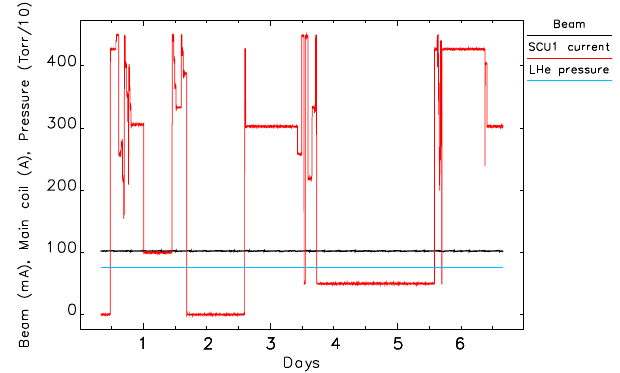
FIG. 13. First week of SCU1 operation. The ring was in top-up mode at 100